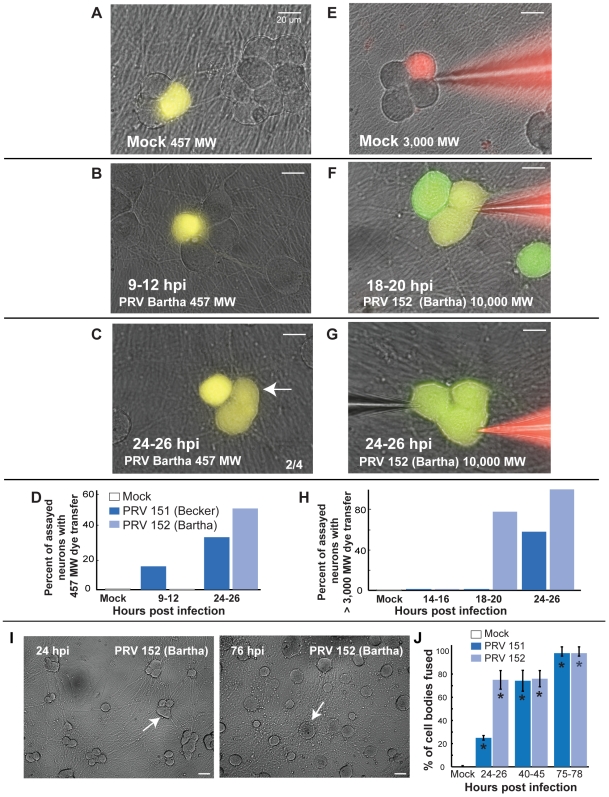
PRV 152 infected neurons follow a similar progression of fluorescent dye transfer and fusion of cell bodies.(A–D) Lucifer yellow (457 MW) dye transfer between PRV 152 infected neurons was delayed until 18 hpi (9–12 hpi, 0/8, 24–26 hpi (2/4). (E–H) Large MW (≥3,000 MW) dye transfer occurred by 18–20 hpi between PRV 152 infected neurons, earlier than occurred between PRV 152 infected neurons (14–16 hpi, 0/3, 18–20 hpi, 7/9, 24–26 hpi, 9/9). (I–J) Representative fields of view of PRV 152 infected neurons and quantification. Note earlier cell body-cell body fusion between PRV 152 infected neurons compared to PRV 151 infected neurons, consistent with that observed in large MW dye experiments. (I–J) PRV 152 24–26 hpi n = 4, 40–45 hpi n = 2 and 75–78 hpi, n = 2. Data were collected displayed as described in Figures 5 and 7.